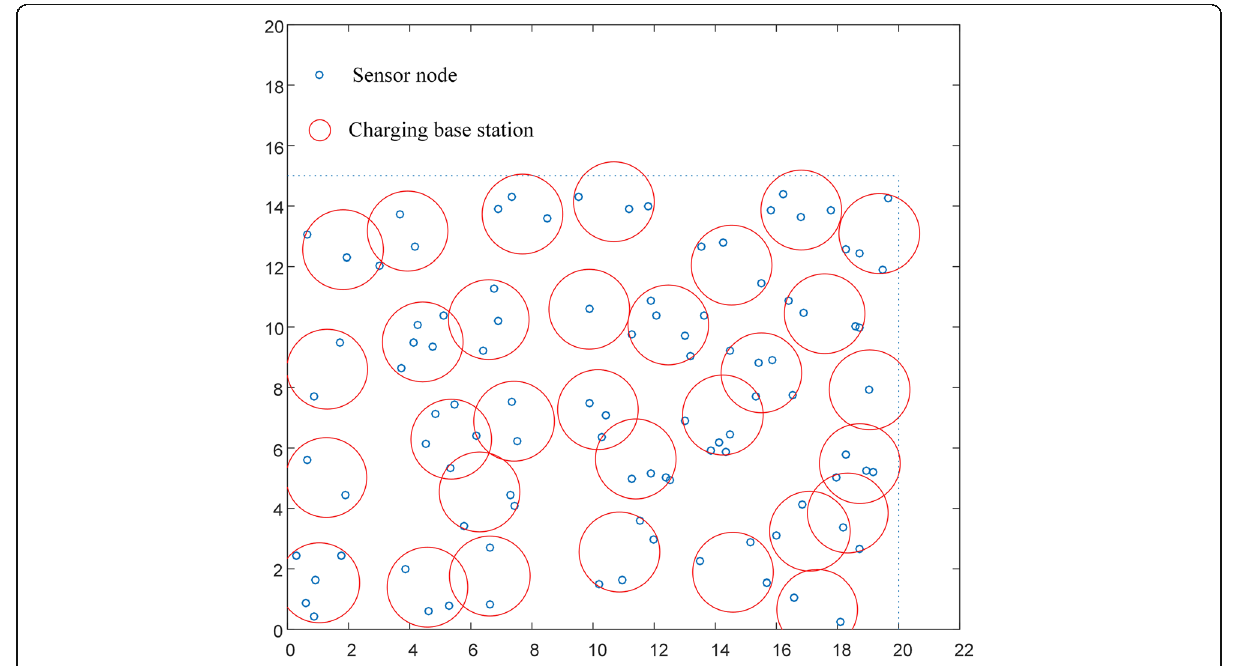
Fig. 4 Simulation result for CCG algorithm when 100% nodes are covered